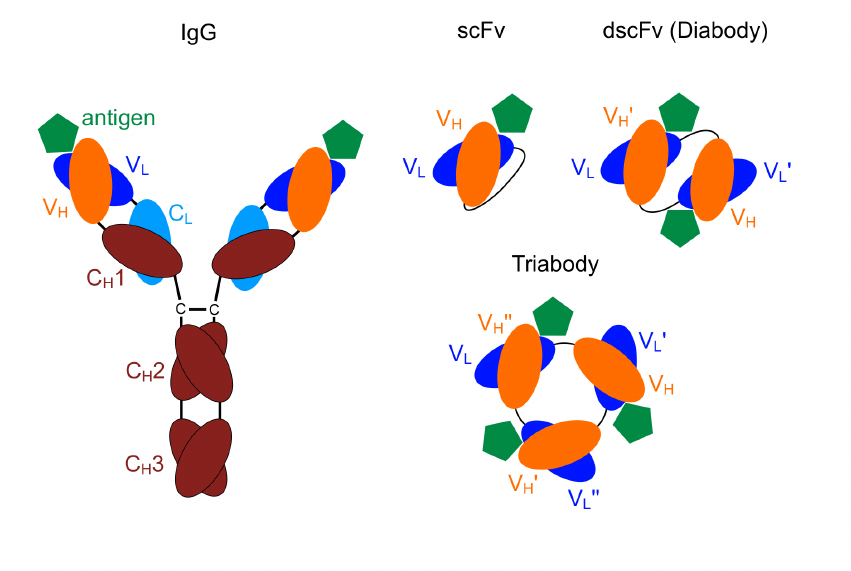
Figure 1. Schematic drawing: immunoglobulin (IgG) including the variable domains, (V H ) and (V L ), single-chain Fv (scFv), diabody, triabody